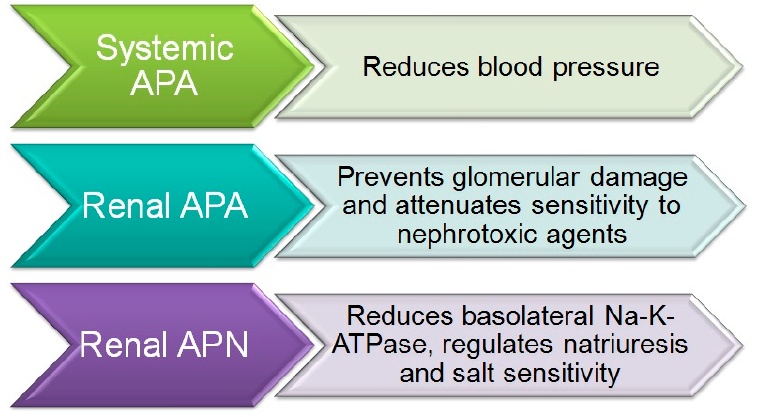
Figure 2. Systemic aminopeptidase A (APA) and aminopeptidase N (APN) in blood pressure control .